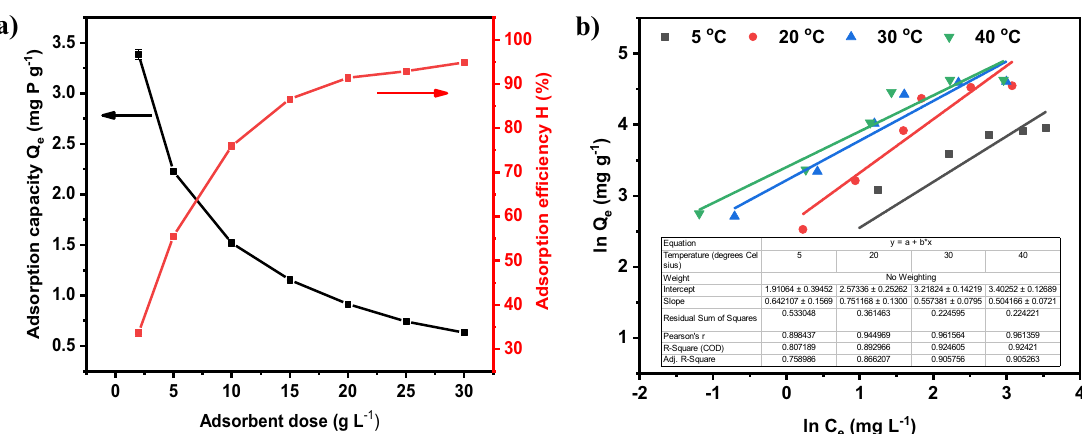
Fig. 3 Effect of dosage and the isotherm plot of Freundlich for the adsorption of phosphate. a Effect of dosage on the adsorption of phosphate with experimental conditions: 50 h, 20 mg P L − 1 , pH 6.0, and room temperature of ∼ 30 °C; b the isotherm plot of Freundlich for the adsorption of phosphate with experimental conditions: 50 h, 10 g (HIAO/225H)/L, pH 6.0 room temperature of ∼ 30 °C; and experimental condition ( n = 3 ±standard deviation